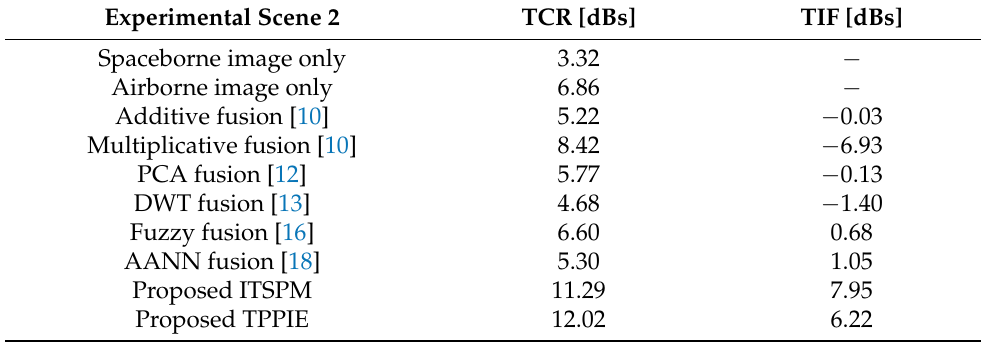
Table 3. TCR and TIF (in dBs) comparisons for Experimental Scene 2. The proposed TPPIE method attained the highest TCR and the proposed ITSPM method attained the highest TIF Experimental Scene